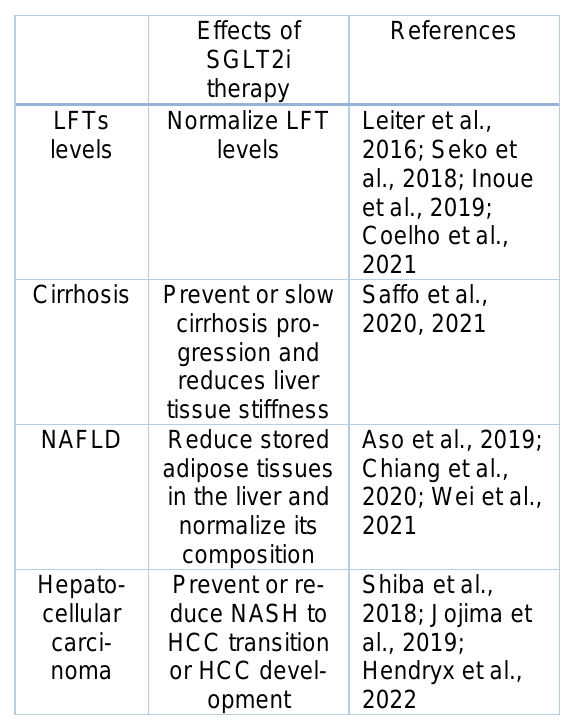
Table 1: Main interactions between SGLT2 inhib- itors and hepatic